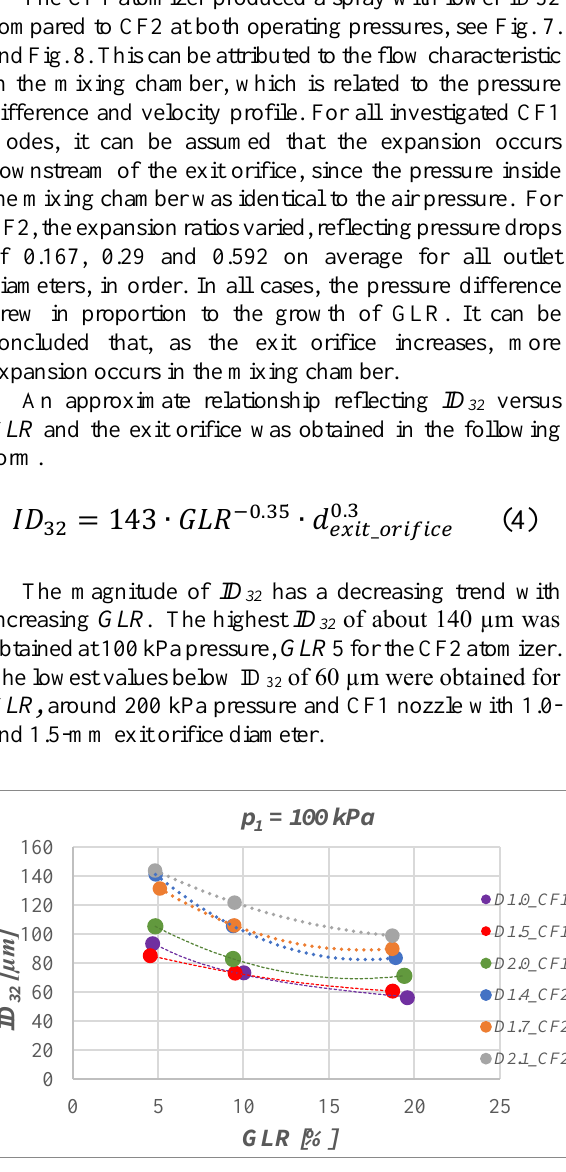
Fig. 7. The influence of GLR on ID 32 for p 1 = 100 kPa .